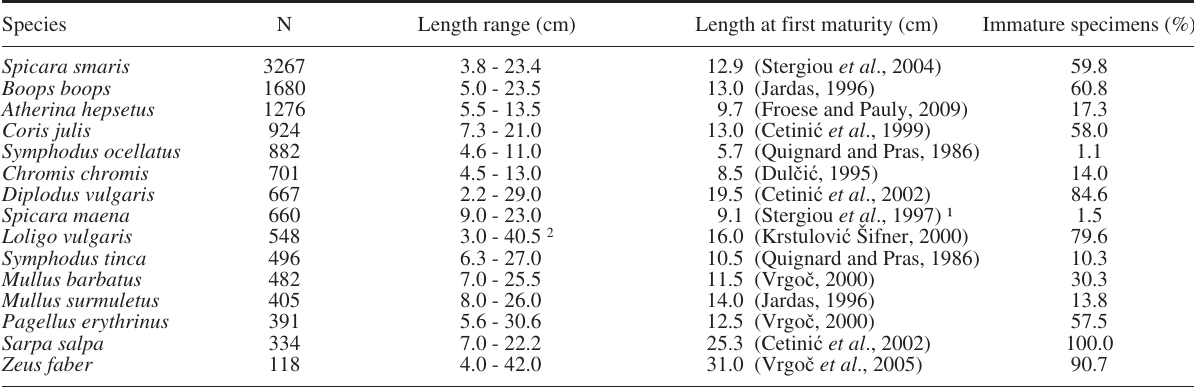
Table 2. – Length range (TL for fish and DML for cephalopods), length at first maturity with references and percentage of immature speci- mens for the dominant species in boat seine catches on Posidonia beds (eastern Adriatic).